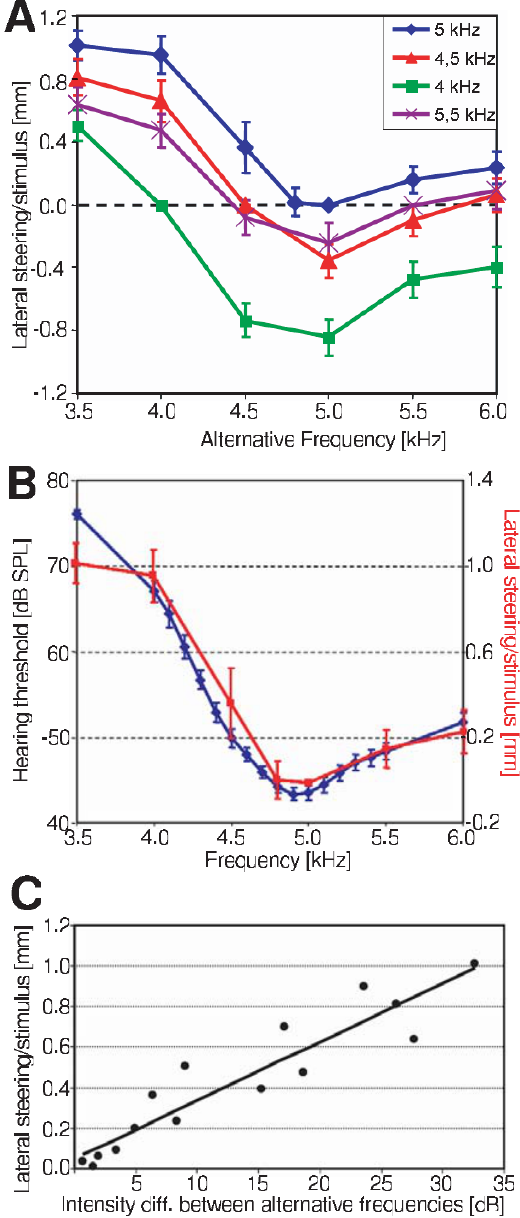
Figure 2. AN1-tuning is highly predictive for female choice. (A): Strength of lateral steering towards or away (positive and negative values, respectively) four calling song frequencies of 4 kHz, 4.5 kHz, 5 kHz and 5.5 kHz in a choice with calling songs ranging from 3.5 to 6 kHz. For example, 5 kHz is preferred against all CFs except 4.8 kHz, and a CF of 4 kHz is rejected in all choices except 3.5 kHz (mean 6 SE; N=20). (B) The average tuning of AN1 (blue; mean 6 SE; N=20) correlates strongly with the behavioural preference (lateral steering towards a CF of 5 kHz in a choice with alternative CFs from 3.5 to 6 kHz, and (C) the degree of lateral steering increases with the intensity difference due to the threshold difference in AN1 for the two alternative